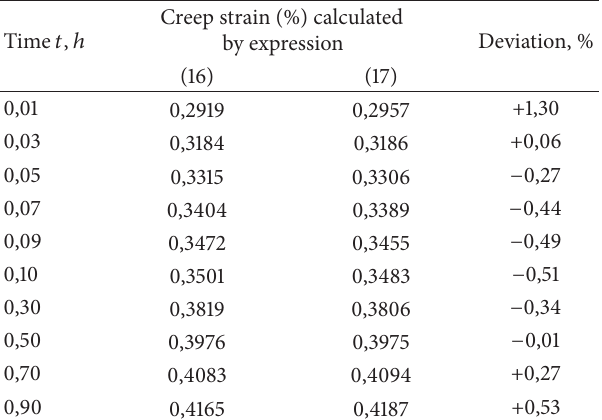
Table 1: Strains in site I of material Nylon 6 creep